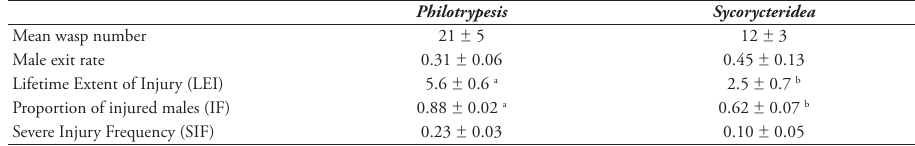
Table 5. Average numbers per fig and injury rates for the two non-pollinating fig wasp species (N = 30 figs).